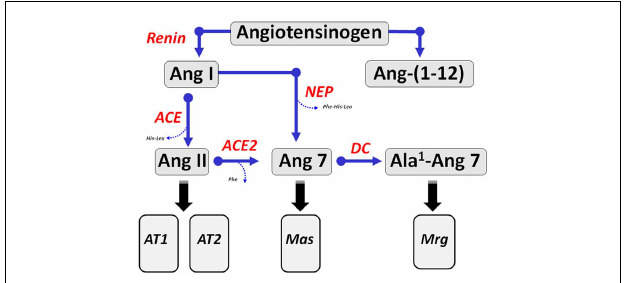
FIGURE 1 | Enzymatic cascade of angiotensin peptide formation and metabolism . Renin cleaves the precursor protein angiotensinogen to angiotensin-(1–10) (Ang I) which is further processed to the biologically active peptides Ang-(1–8) (Ang II) by angiotensin converting enzyme (ACE) and Ang-(1–7) by endopeptidases such as neprilysin (NEP). Ang II undergoes further processing at the carboxyl terminus by the carboxypeptidase ACE2 to yield Ang-(1–7) (Ang 7). Ang-(1–7) undergoes decarboxylation (DC) of the aspartic acid residue to form Ala 1 -Ang-(1–7) (Ala 1 -Ang 7).The dodecapeptide Ang-(1–12) is derived from the hydrolysis of theTyr 12 -Tyr 13 bond of rat angiotensinogen by an unknown enzymatic pathway. Ang II recognizes both AT 1 and AT 2 receptors. Ang-(1–7) activates the Mas receptor and Ala 1 -Ang-(1–7) recognizes the Mas-D related receptor